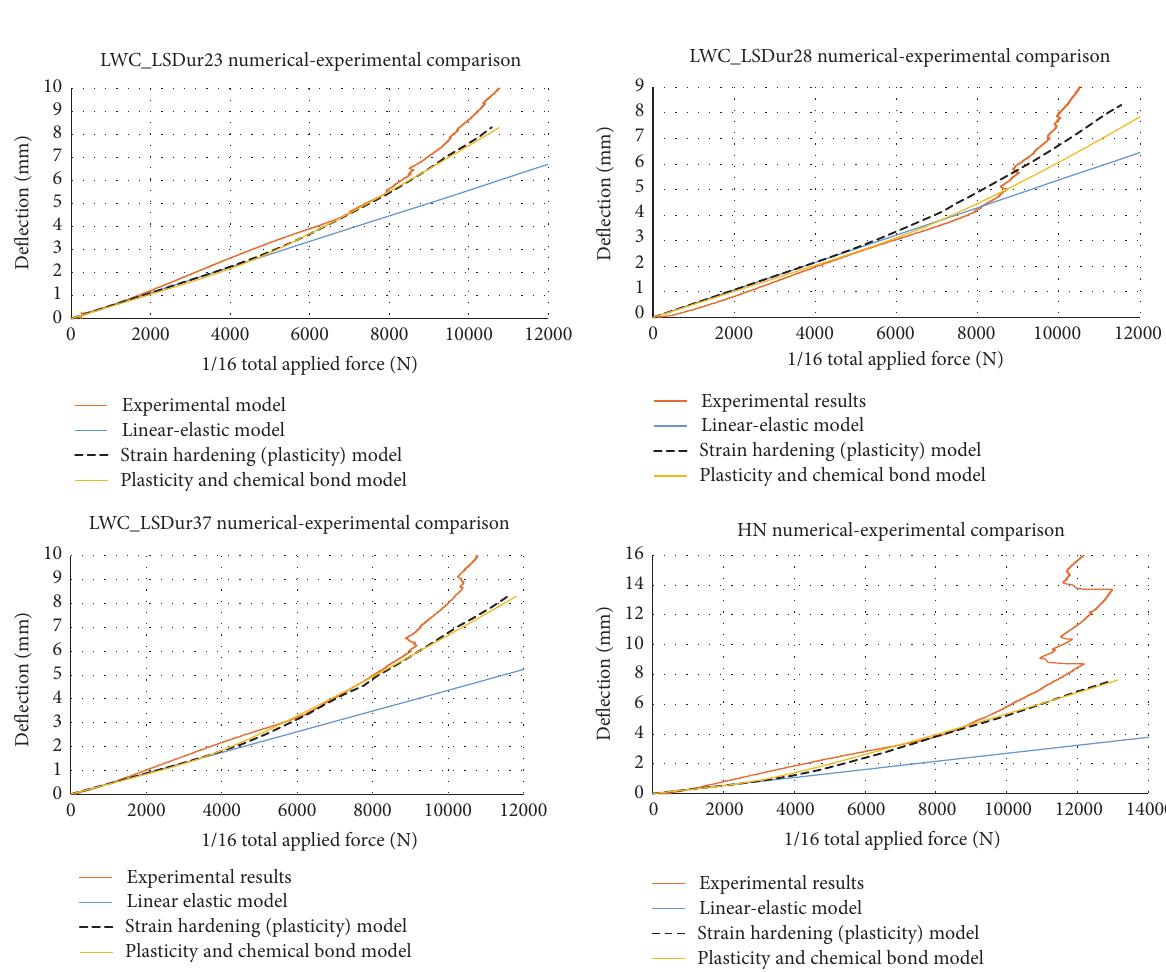
Figure 11: Comparison numerical-experimental results for 2610mm composite